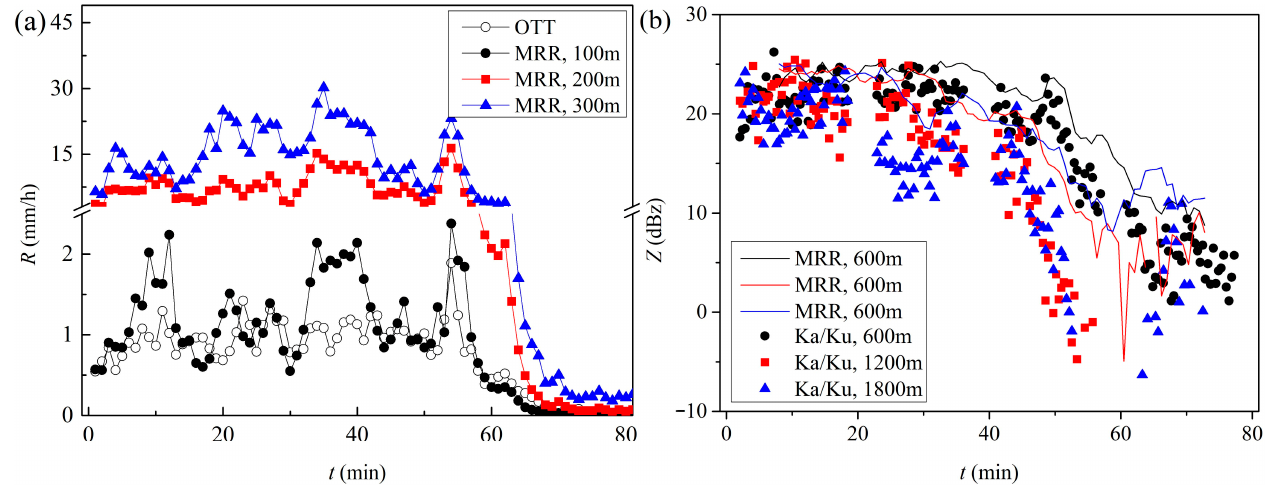
Figure 3. Consistency verification of monitoring devices. ( a ) R values obtained by MRR and OTT; ( b ) Z values obtained by Ka − Ku and MRR.